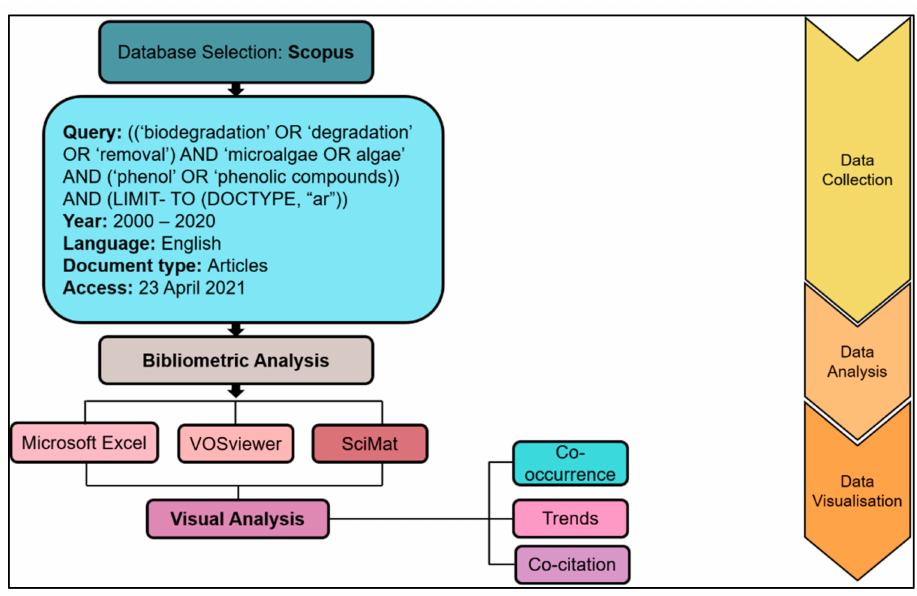
Figure 1. The workflow of the bibliometric analysis.